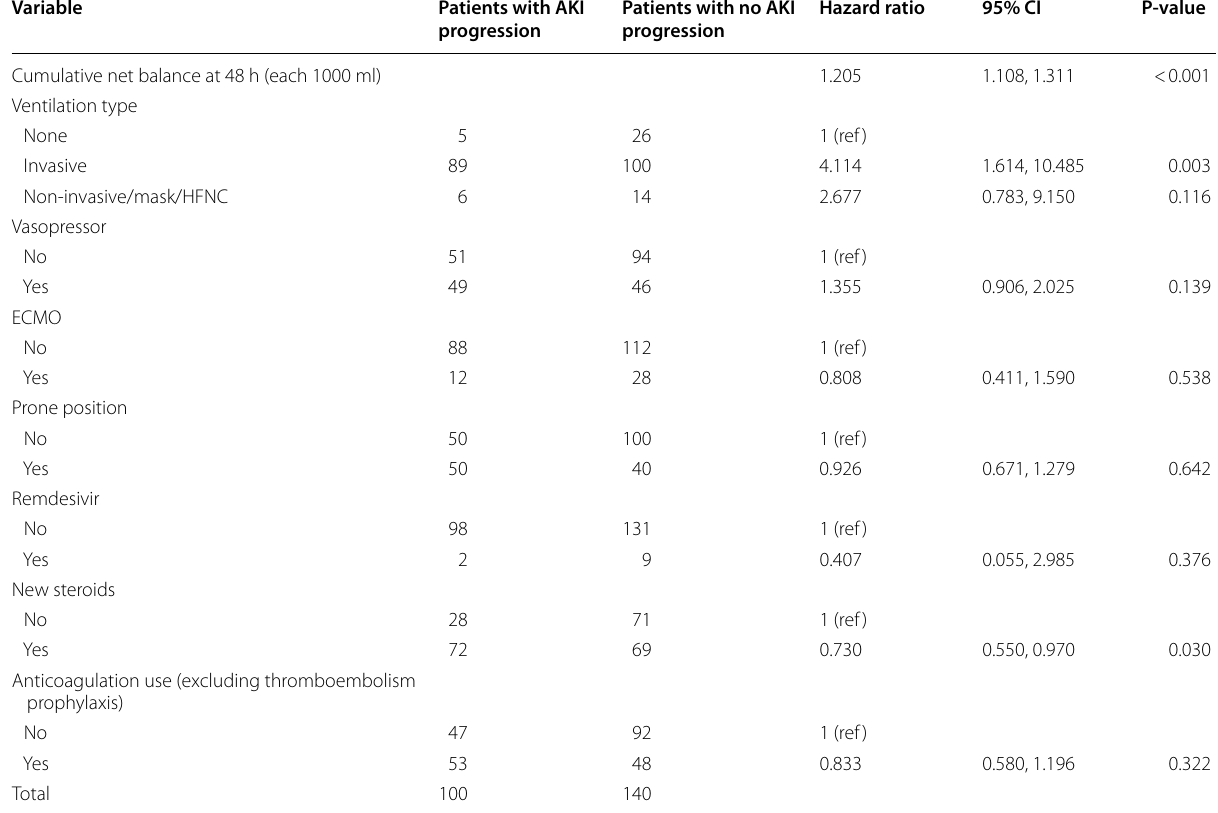
Table 3 Adjusted* hazard ratios for acute kidney injury progression in intensive care unit according to